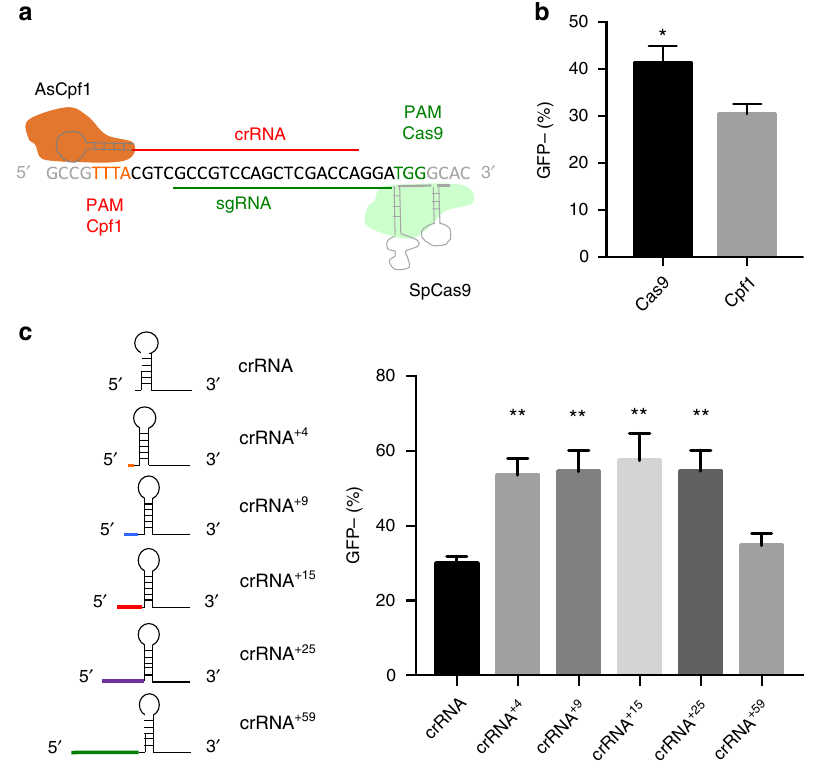
Fig. 2 5 ′ -End extensions of the crRNA enhance the gene editing of Cpf1 in HEK cells. a Sequence of the GFP protospacer that is targeted by both AsCpf1 and SpCas9. b Electroporation of SpCas9 and AsCfp1 RNP targeting the GFP-matched site demonstrate that SpCas9 can knock out genes more ef fi ciently than Cpf1. Mean± SE, n = 4. * p < 0.05 by Student ’ s t test. c 5 ′ Sequence extension of crRNA increases Cpf1 gene editing in GFP-HEK cells. Cpf1 RNP + with various 5 ′ extended crRNAs were delivered to GFP-HEK cells using electroporation. Four nucleotide to twenty- fi ve nucleotide extension signi fi cantly increased editing ef fi ciency. Mean± SE, n = 3. ** p < 0.01 by Student ’ s t test compared to crRNA